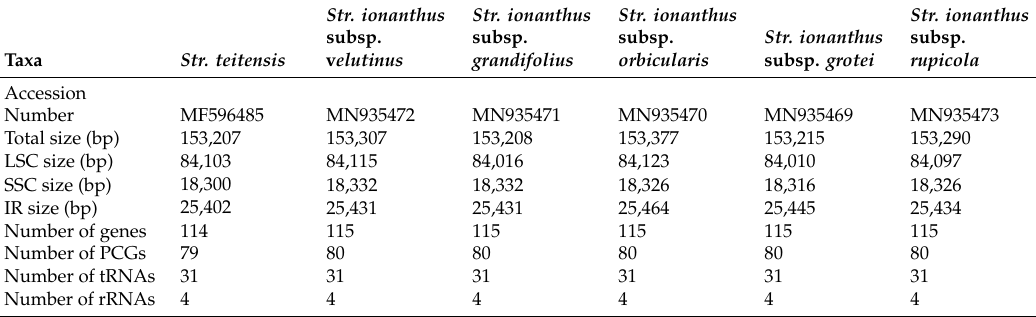
Table 1. Characteristics of major features of six sect. Saintpaulia chloroplast genomes.